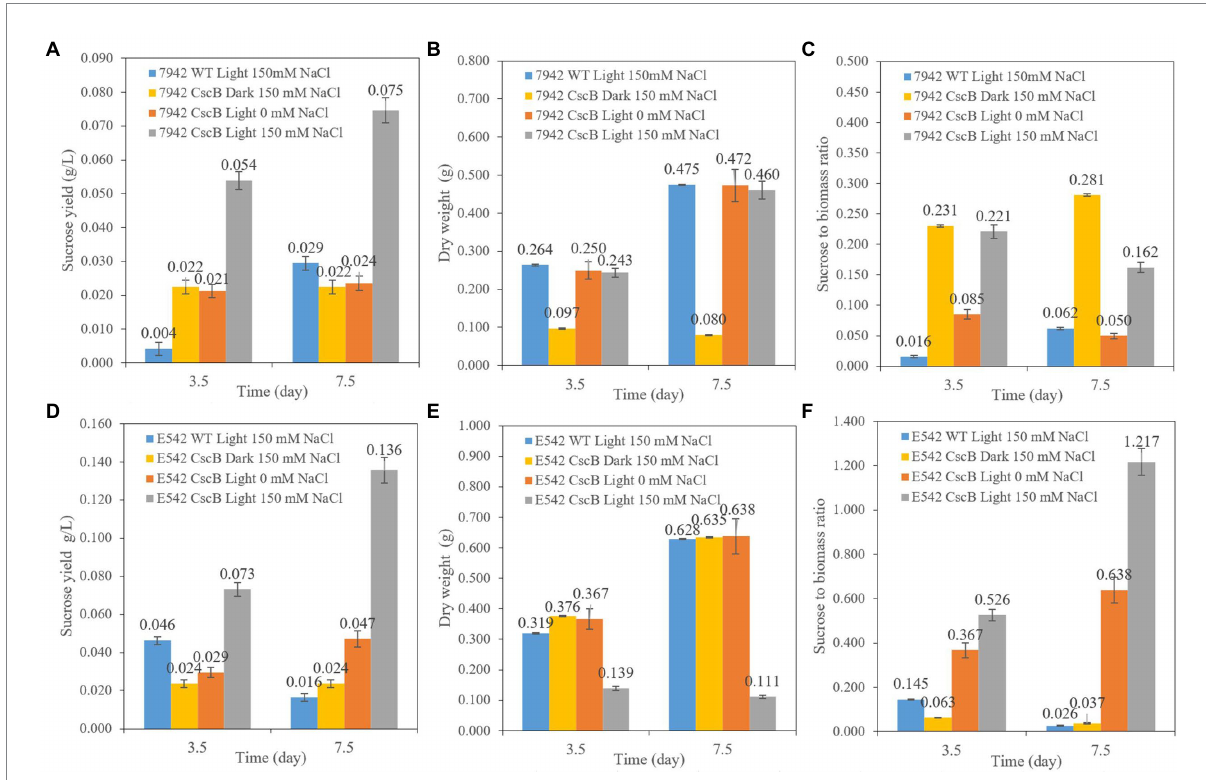
FIGURE 2 The comparison of sucrose yield of the PCC7942_ cscB + (A) , E542 _cscB + (D) , accumulated dry weight (B,E) , and sucrose to biomass ratio (C,F) grown under different light and osmotic pressure in BG11 growth medium. Height of the bars shows the mean of three independent experiments with error bars representing SD from